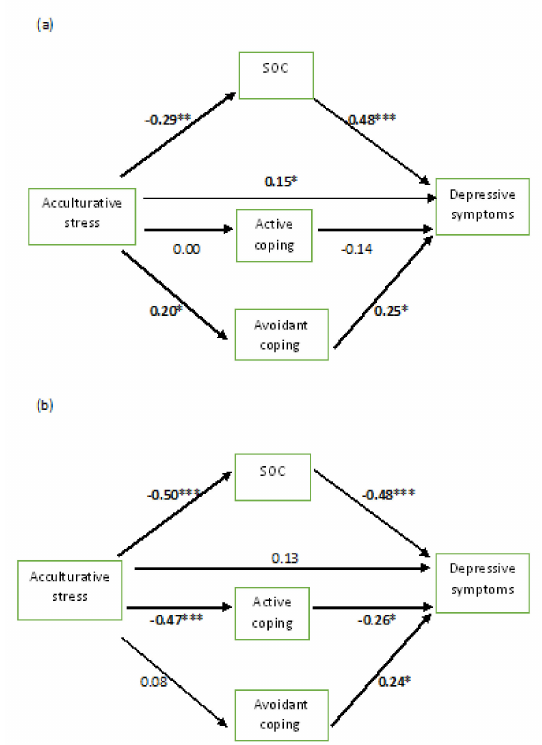
Figure 2. Direct and indirect e ff ects of acculturative stress on depressive symptoms through SOC, avoidant coping, and active coping among: ( a ) female Arab students; and ( b ) male Arab students. Note. All of the coe ffi cients in the figures are standardized. * p < 0.05; ** p < 0.01; *** p < 0.001; SOC, sense of